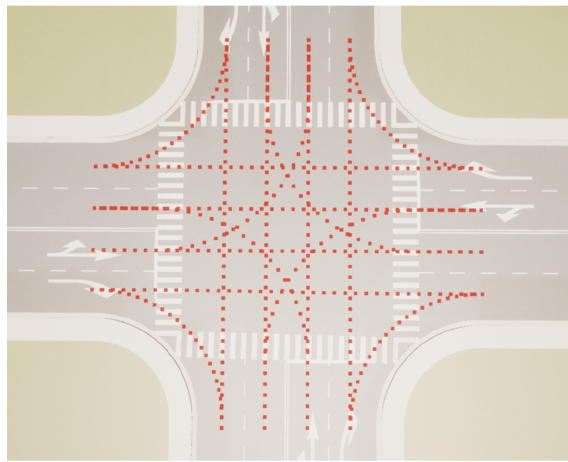
Figure 4. Waypoints at the road junction. Algorithm 1. Reference waypoints’ set acquisition algorithm in each